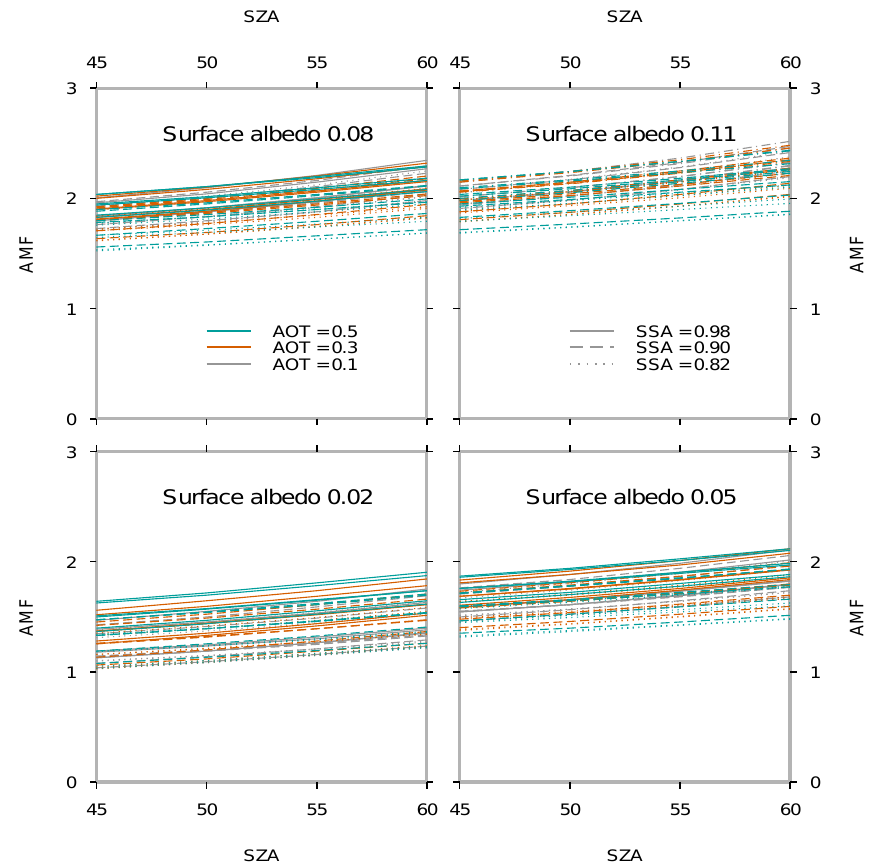
Figure 5. Calculated air-mass factors from the six low surface elevation (sea level) scenarios outlined in Fig. 4, plotted as a function of solar zenith angle and surface albedo. A dotted line indicates ω = 0.82, a dashed line ω = 0 . 90, and a solid line ω = 0 . 98. AOT is indicated by line colour: grey for AOT = 0.1, orange for AOT = 0.3, and blue-green for AOT =